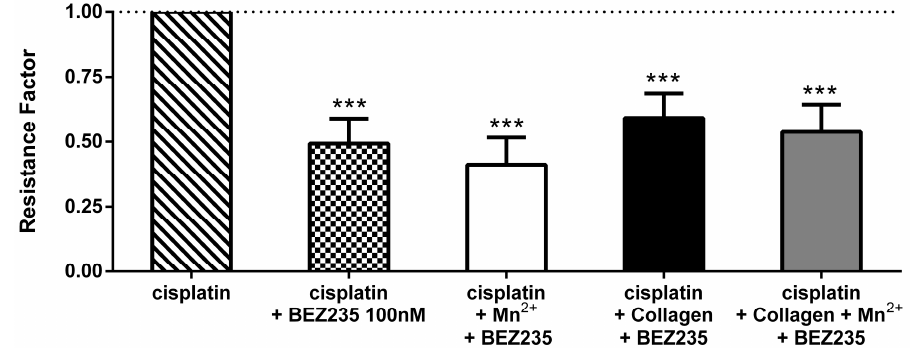
Figure 4. Change in cisplatin resistance factors under PI3K inhibition. Cells (10 4 cells/well) were incubated with integrin activators concomitantly with PI3K inhibitor BEZ235 (100 nM) for 6 h, before the addition of cisplatin. BEZ235 is depicted alone or with additional integrin activating stimuli: treatment with 1 mM manganese or collagen coating. After 72 h, MTT assay was performed revealing a strong increase in sensitivity in all cells treated with the BEZ235. This highlights the relevance of PI3K signalling for cells to survive cisplatin treatment and suggests an important role of integrins in cell survival against chemotherapeutic treatment. Measurements were conducted in triplicates (at least n = 3). Asterisks indicate statistical significance: * p < 0.05; ** p < 0.01; *** p < 0.001.